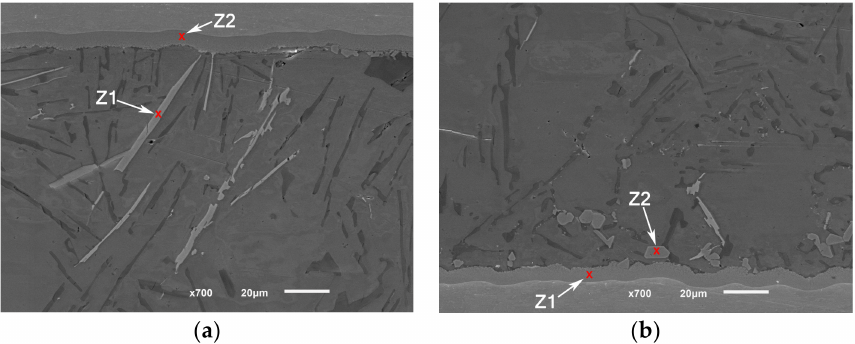
Figure 23. SEM images (SEI) of a 13/680 brazed joint: ( a ) The active parent part interface with the filler; ( b ) The passive part interface. EDS analyses results are shown in Table